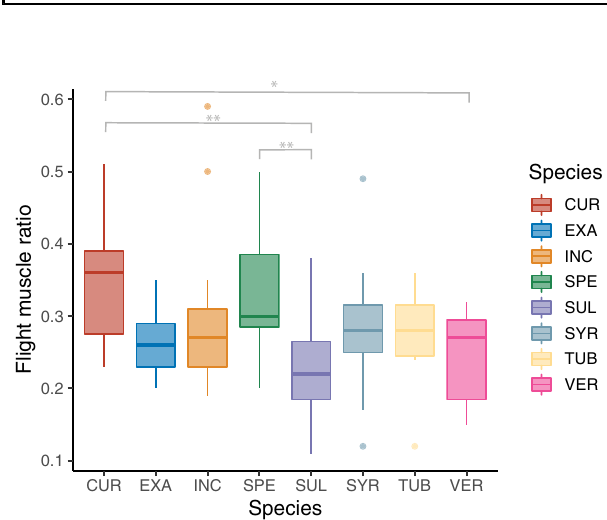
Fig. 1 Adult fl ight muscle ratio as a function of larval host plant. Each box represents one milkweed species. CUR, A. curassavica; EXA, A. exaltata; HIR, A. hirtella; INC, A. incarnata; LAE, C. laeve; SPE, A. speciosa; SUL, A. sullivantii; SYR, A. syriaca; TUB, A. tuberosa; VER, A. verticillata; top horizontal bar in box represents third quartile, followed by median and fi rst quartile; whiskers indicate data range. Connecting bars indicate signi fi cant post-hoc LS means comparisons (Tukey HSD).